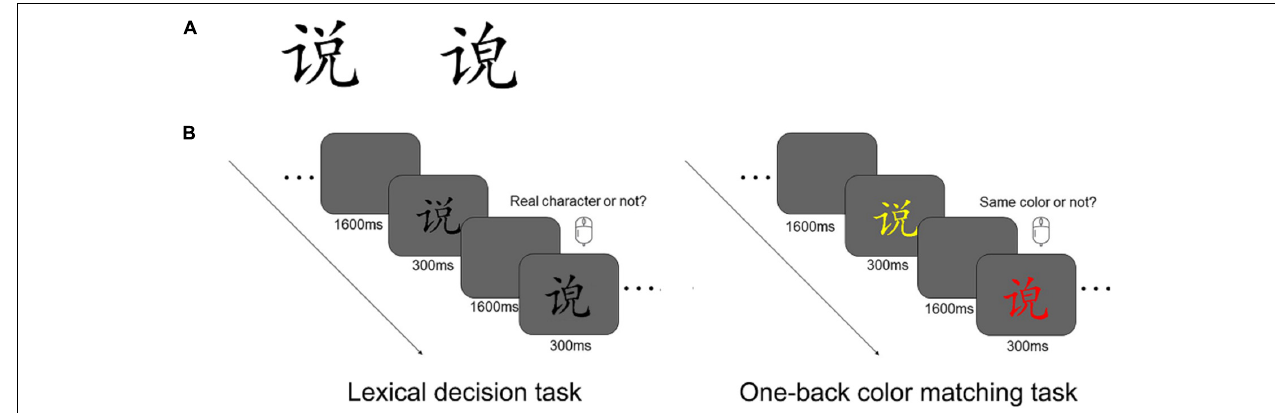
FIGURE 1 | (A) Sample real (left) and pseudo (right) characters. (B) The lexical decision task (left panel) and the one-back color matching task (right panel). The lexical decision task was used to group the participants, whereas the color matching task was used to examine the neural responses associated with automatic